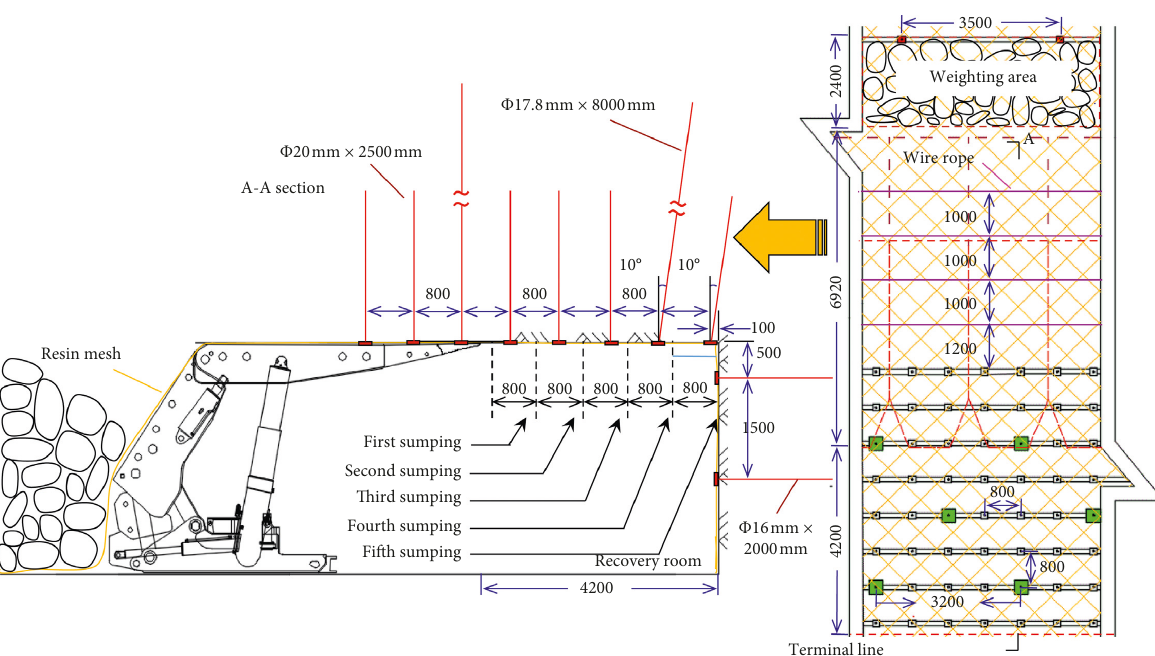
Figure 8: Improved support design of the recovery